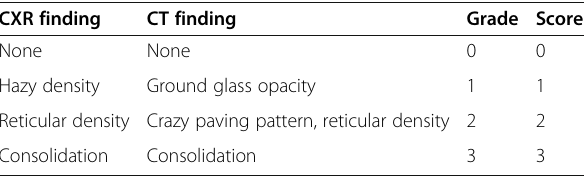
Table 1 Grading system based on the density and morphology of the lesions